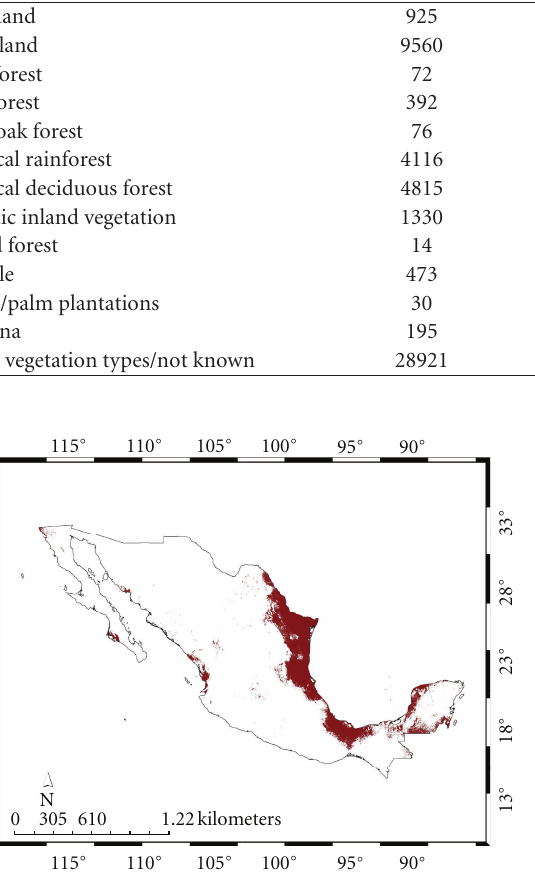
Figure 1: Species distribution model for Amblyomma cajennense . Figure 2: Species distribution model for the Ixodes group.